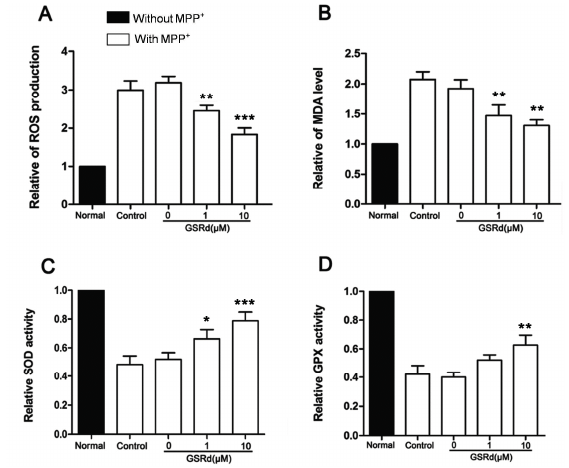
Figure 2. Effects of ginsenoside Rd (GSRd) on reactive oxygen species (ROS), malondialdehyde (MDA) levels and antioxidant enzymatic activities in MPP + treated SH-SY5Y cells. ( A , B ) Relative intracellular ROS accumulation and MDA level in 1-methyl-4-phenylpyridinium (MPP + ) treated SH-SY5Y cells with or without GSRd treatment; ( C , D ) Antioxidant enzymatic activities (C,superoxide dismutase, SOD; D, glutathione peroxidase, GPX) in MPP + treated SH-SY5Y cells with or without GSRd. * p < 0.05; ** p < 0.01; and *** p < 0.001 vs. control